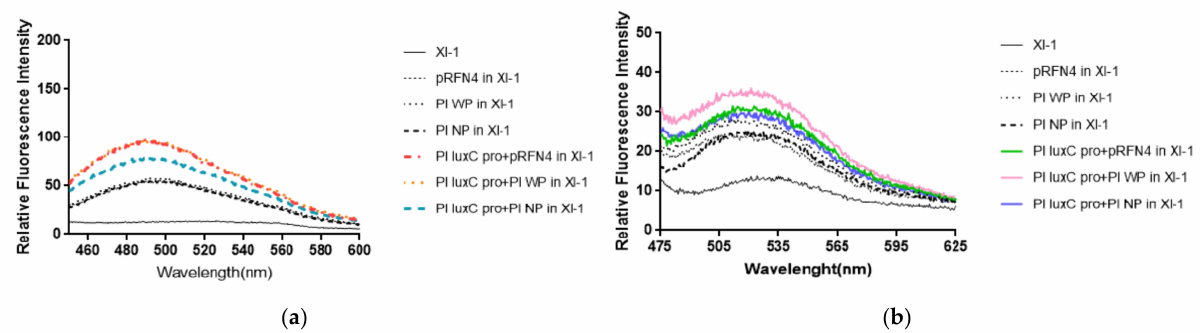
Figure 5. The fluorescence properties of E. coli XL-1 Blue transformed with recombinant plasmids of pRFN4 comtainin the lux gene from P. leiognathi . ( a ) Emission spectrum by lumazine in fixation at excitation wavelength of 410 nm. ( b ) Emission spectrum by riboflavin excited at excitation wavelength of 450 nm. NP and WP denote N- lum P and W- lum P,